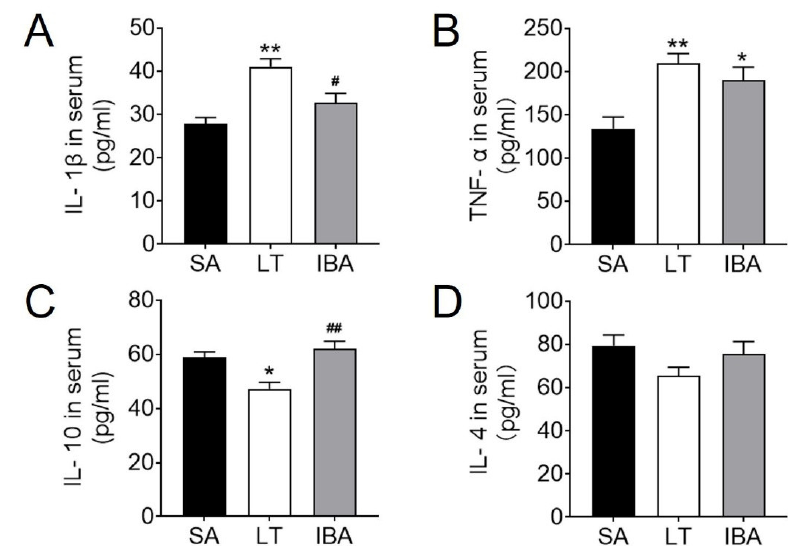
Figure 2. Serum levels of inflammatory factors in ground squirrels. ( A ) Serum levels of pro-inflammatory factor IL-1β. ( B ) Serum levels of pro-inflammatory factor TNF-α. ( C ) Serum levels of anti-inflammatory factor IL-10. ( D ) Serum levels of anti-inflammatory factor IL-4. SA: summer active, LT: late torpor, IBA: interbout arousal. Data are mean ± SEM, n = 6. Significant differences between SA conditions are denoted as follows: * p < 0.05, ** p < 0.01, whereas significant differences in IBA as compared with LT are denoted by # p < 0.05, ## p < 0.01.